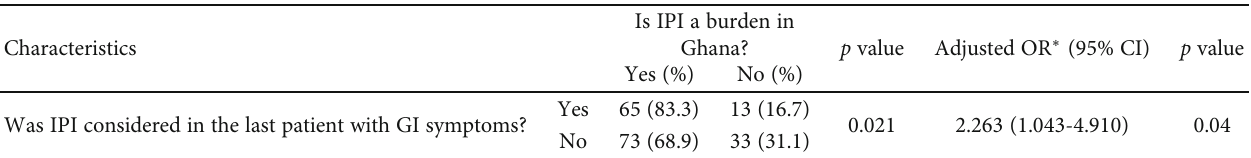
Table 4: Association between the perception of IPI as a burden and considering IPI as a diagnosis in the last patient with gastrointestinal